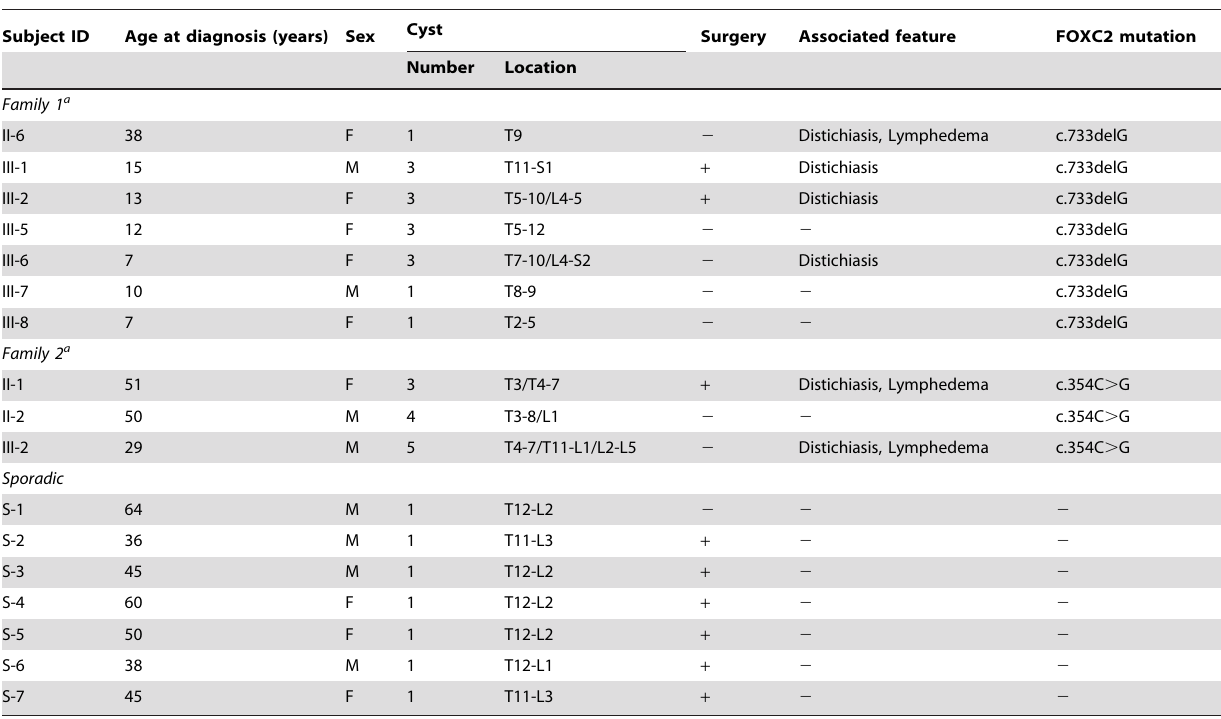
Table 1. Clinical data of spinal extradural arachnoid cyst subjects.